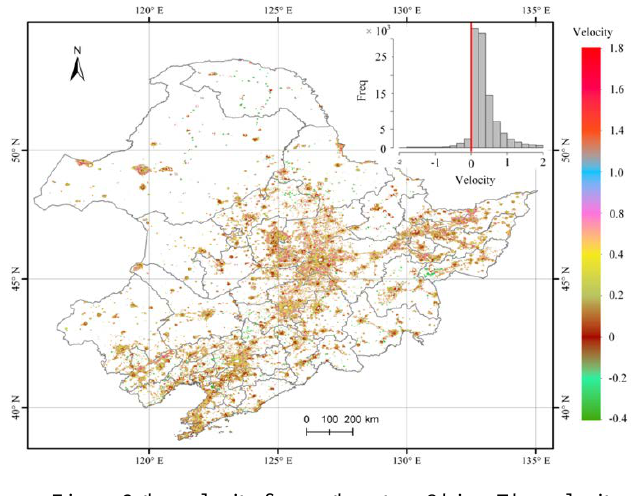
Figure.3 the velocity for northeastern China. The velocity unit is km/yr.